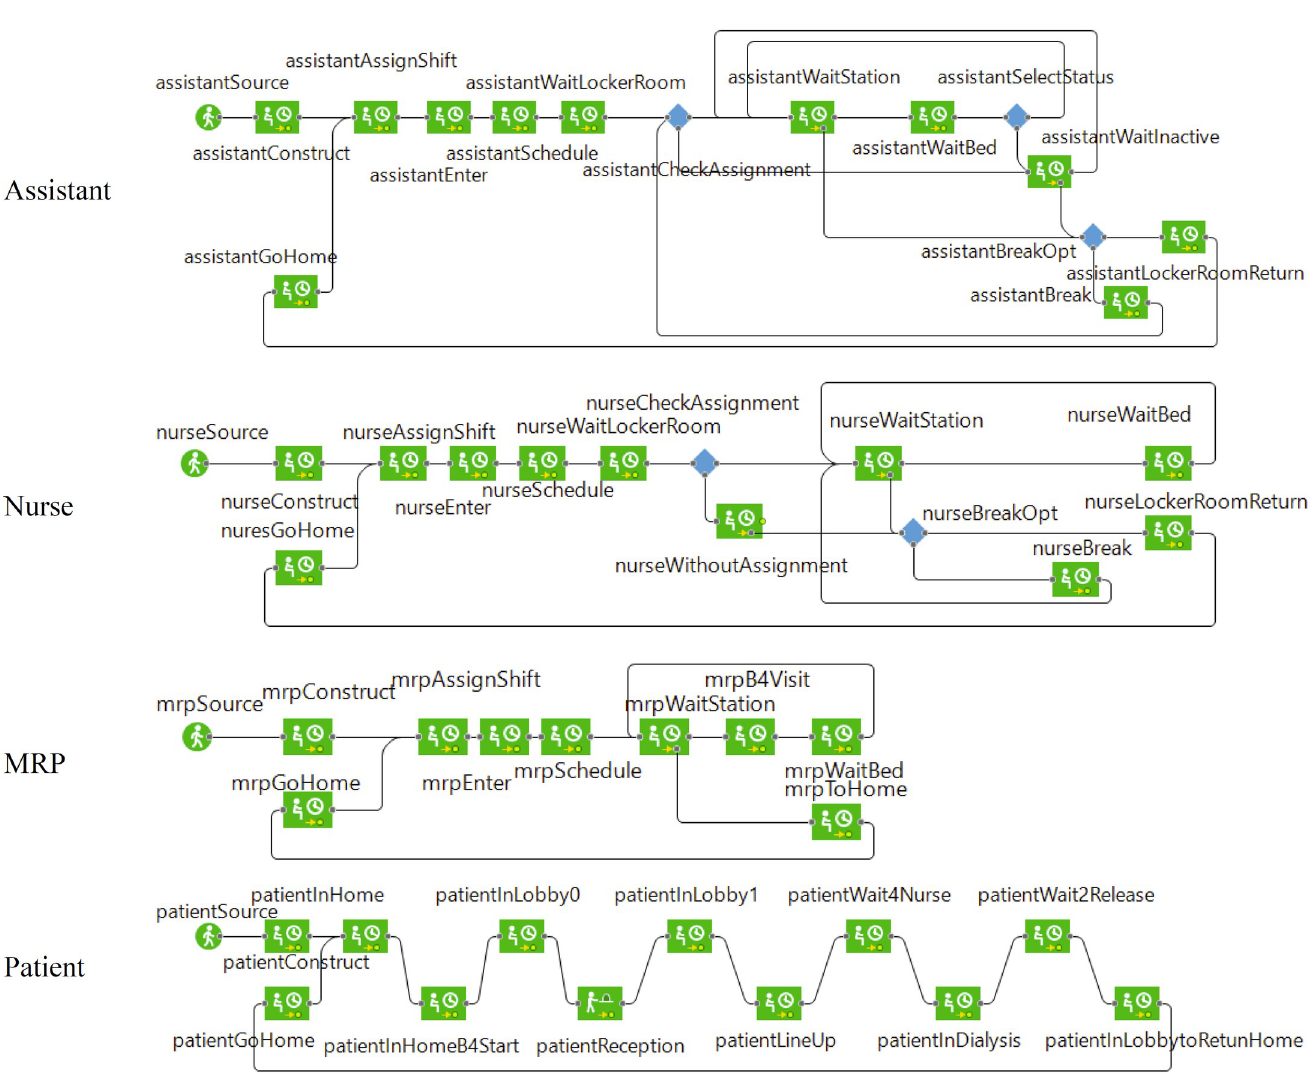
Fig 3. Workflow of selected active agents in AnyLogic 1 pedestrian model.